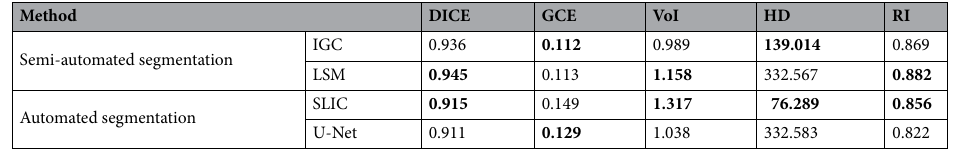
Table 1. Results of five similarity indicators comparing segmentation results of each algorithm and the ground truth. The bold values indicate the best results. When we evaluate the similarity of psoriasis segmentation images and GT, LSM is best in the semi-automated segmentation methods and SLIC superpixels in the automated segmentation methods. DICE dice similarity coefficient, GCE global consistency error, VoI variation of information; HD Hausdorff distance; RI Rand